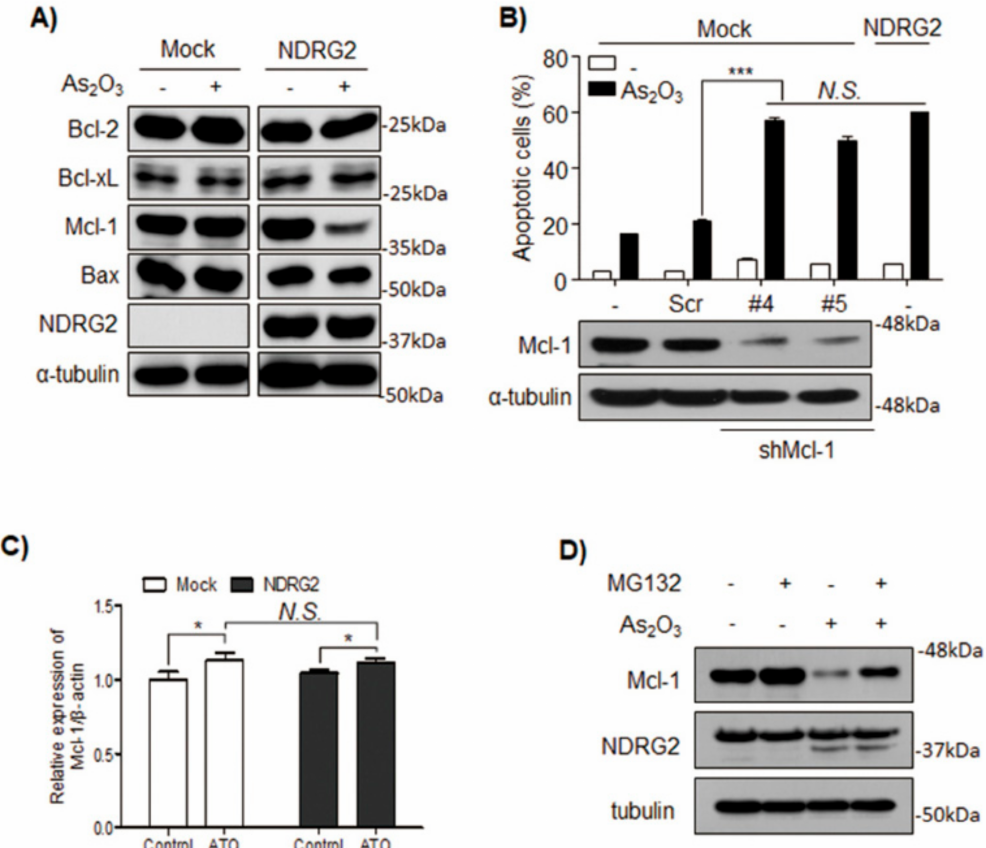
Figure 2. The sensitivity of U937-NDRG2 to As 2 O 3 is mediated through Mcl-1 degradation. ( A ) Expression levels of pro-apoptotic Bcl-2 family protein (Bax) and pro-survival Bcl-2 family protein were analyzed by immunoblotting. ( B )U937-MockwasinfectedbyalentivirusexpressingscrorshorthairpinMcl-1(shMcl-1) (clone #4 and #5). Successful knockdown of Mcl-1 was confirmed by immunoblotting, and apoptotic rate was analyzed using flow cytometry. ( C ) Mcl-1 messenger RNA (mRNA) expression in U937-Mock and U937-NDRG2 in the presence or absence of As 2 O 3 was validated by qRT-PCR. ( D ) Cells were treated with As 2 O 3 in the presence or absence of MG132, and then protein level of Mcl-1 was confirmed by immunoblotting. N.S .: Non-significant. * p < 0.05, *** p < 0.005 determined from t -test. Data are presented as means ±